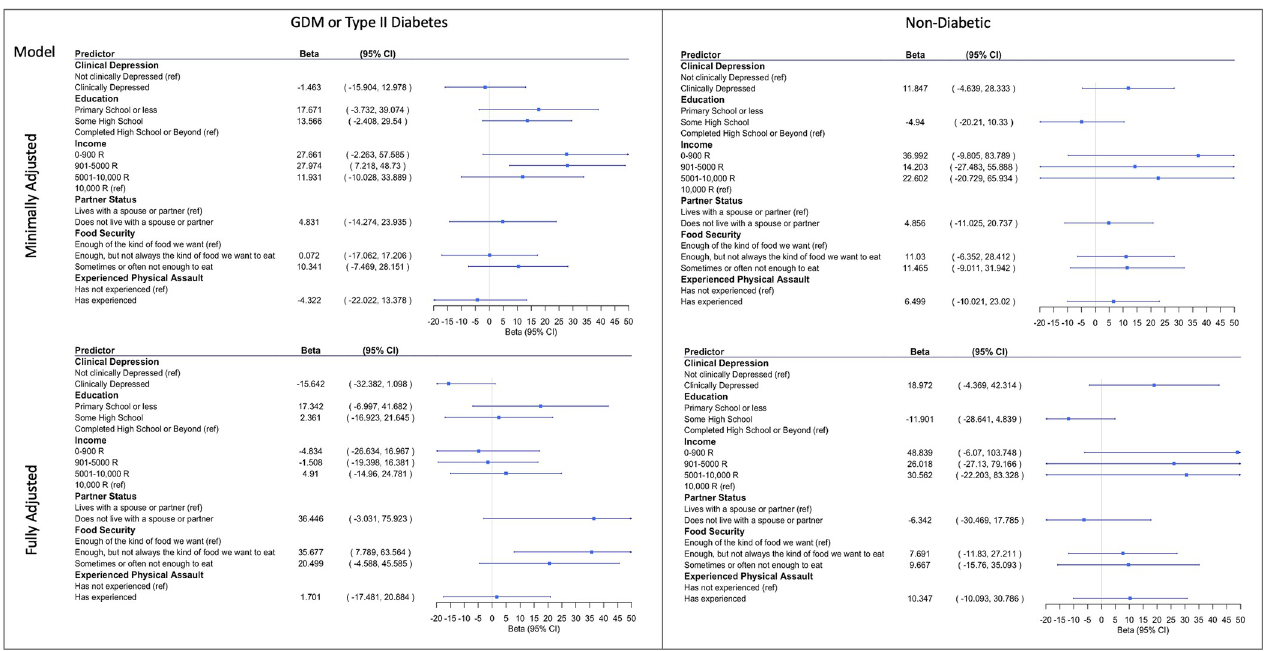
Fig 5. Stratified by diabetes betas and 95% CI for ASQ:SE:2 score. Minimally adjusted model was adjusted for maternal age. Fully adjusted model was adjusted for maternal age as well as the other maternal experiences. Maternal physical assault and income were analyzed in separate